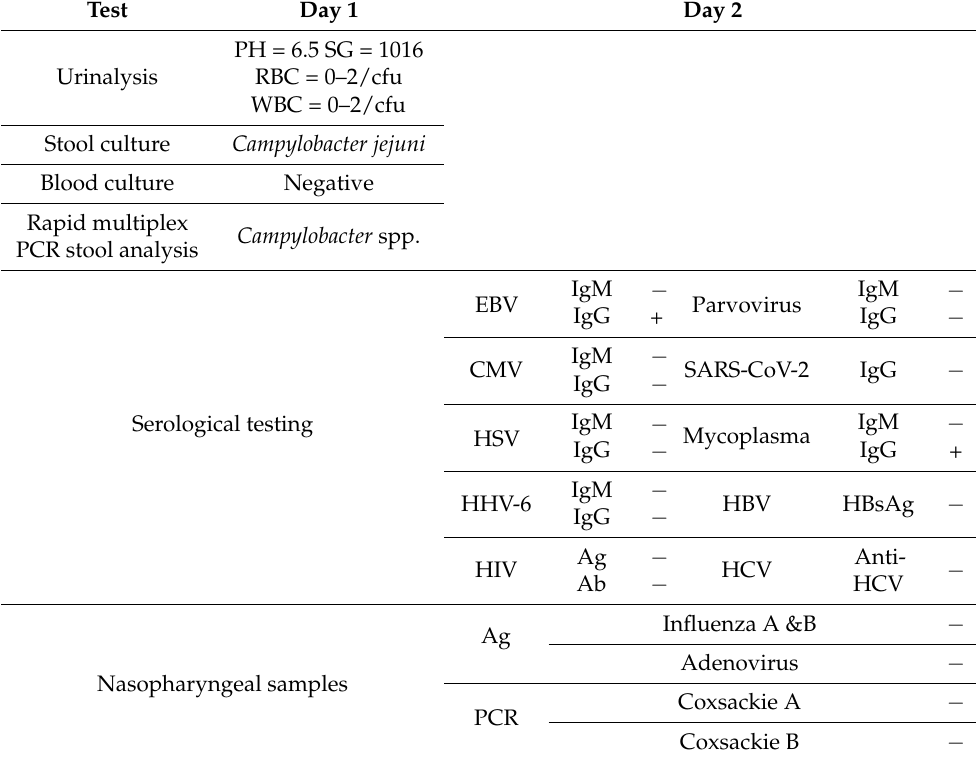
Table 2. Microbiological tests.